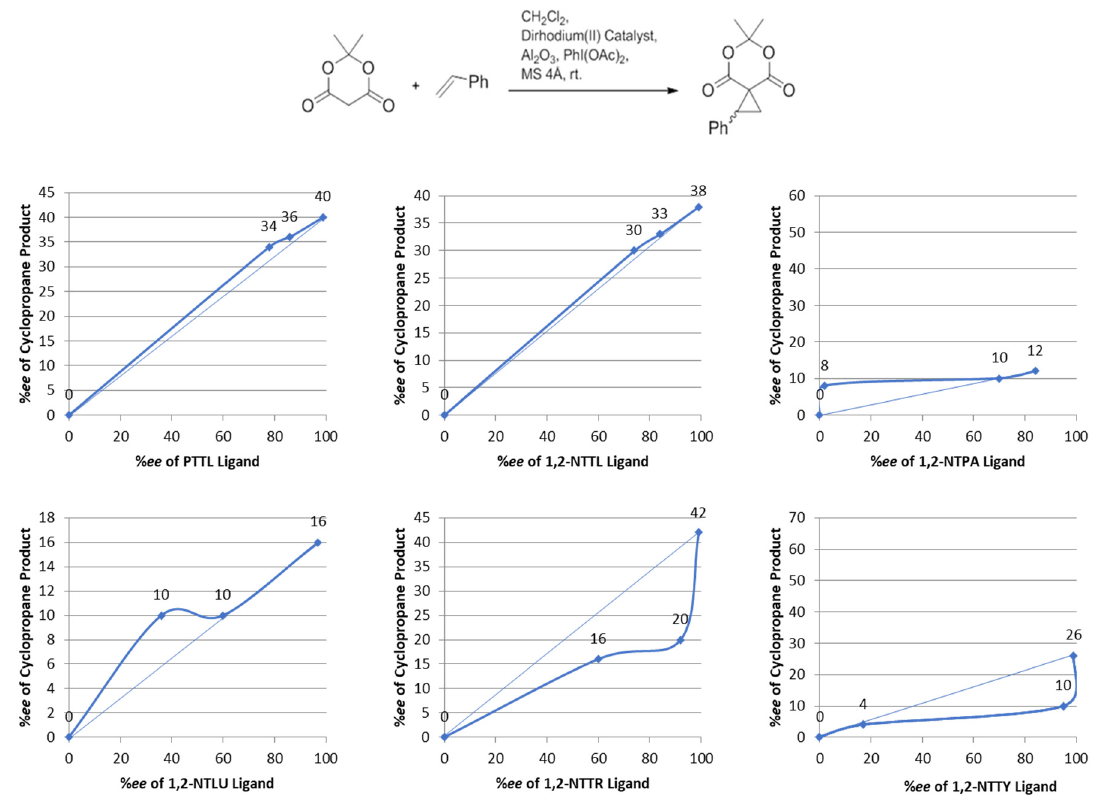
Figure 5. Effect of ligand enantio ‐ purity on the enantioselectivity of its corresponding dirhodium(II) catalyst.